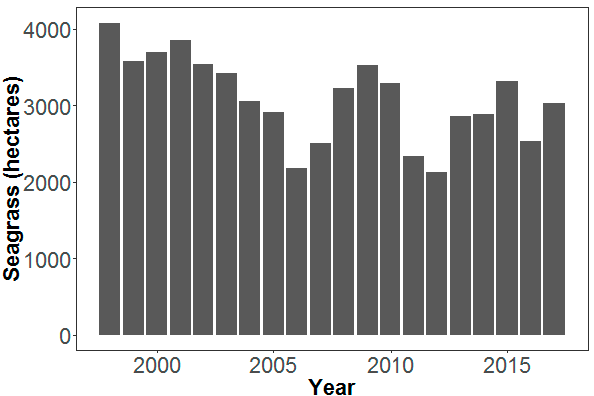
Figure 5. Linear relationship between the length of the previous summer stressful season and seagrass coverage (hectares). Seagrass hectares were calculated from the VIMS annual aerial mapping survey. Only years where data for both seagrass coverage and the length of the season were available are included. y = − 22x + 5706; p < 0.01; r 2 = 0.17.